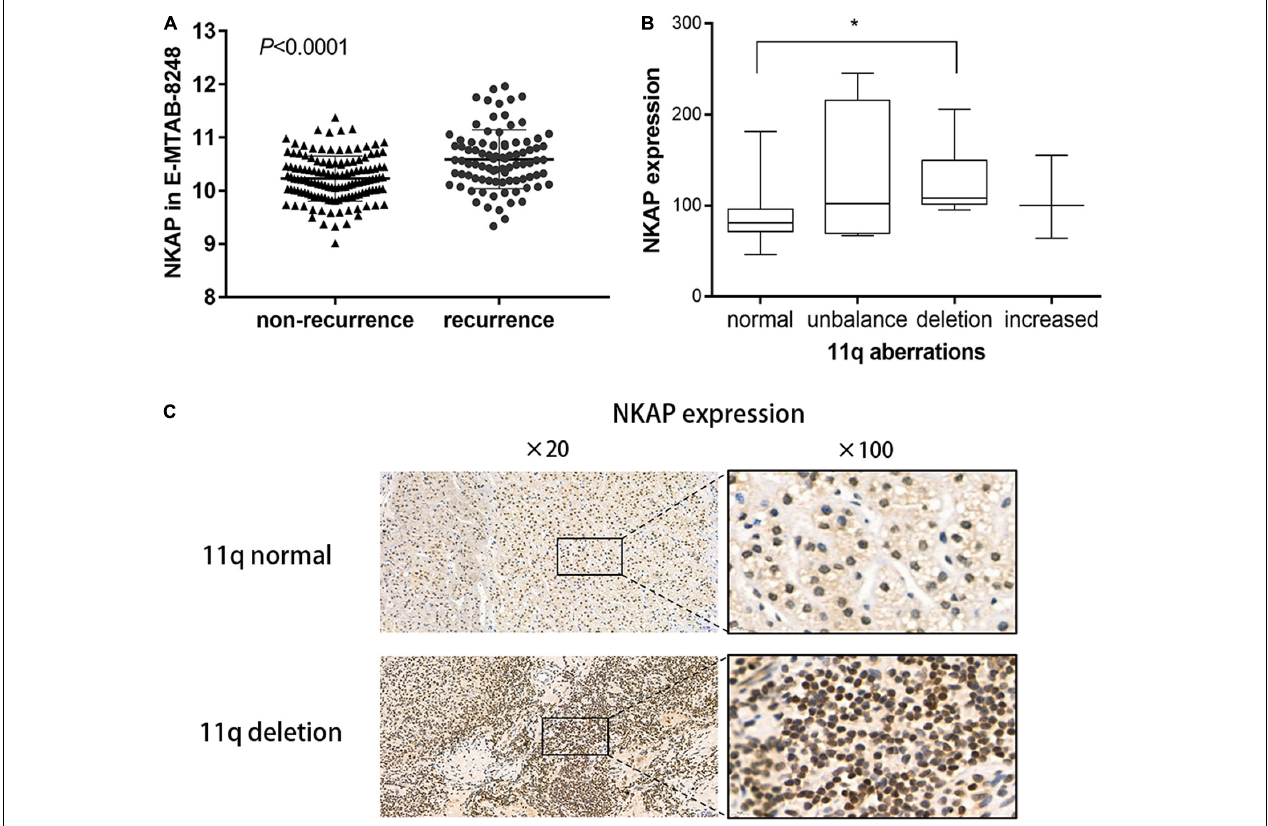
FIGURE 1 | Expression of NKAP in human neuroblastoma tissue. (A) Difference of NKAP gene between non-relapse group and relapse group of NB tissues. (B) Box figure of NKAP expression among different 11q aberration patterns. 11q normal and 11q deletion show a statistical difference in NKAP expression. (C) IHC analysis of NB children with tissue 11q normal and 11q deletion. * P <